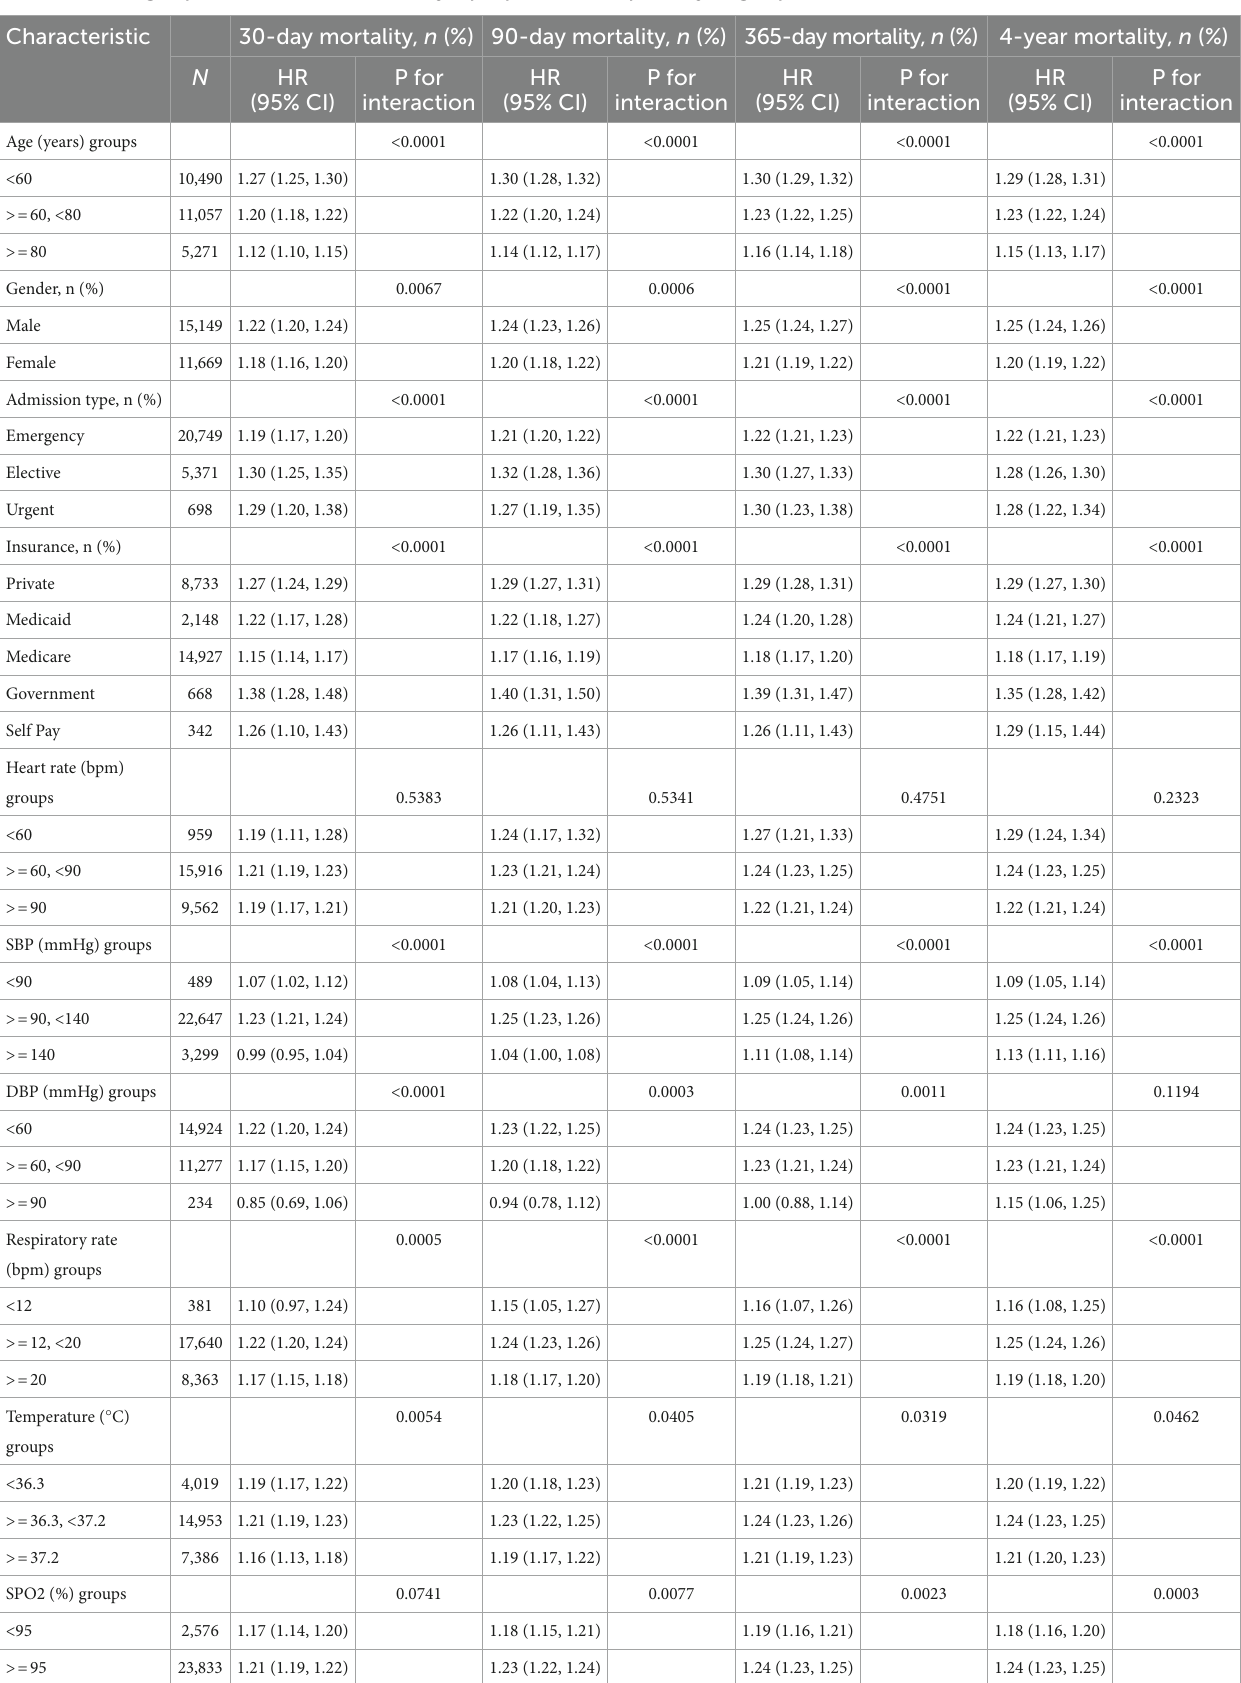
TABLE 3 Each subgroup’s RWD effect size on mortality in prespecified and exploratory subgroups.